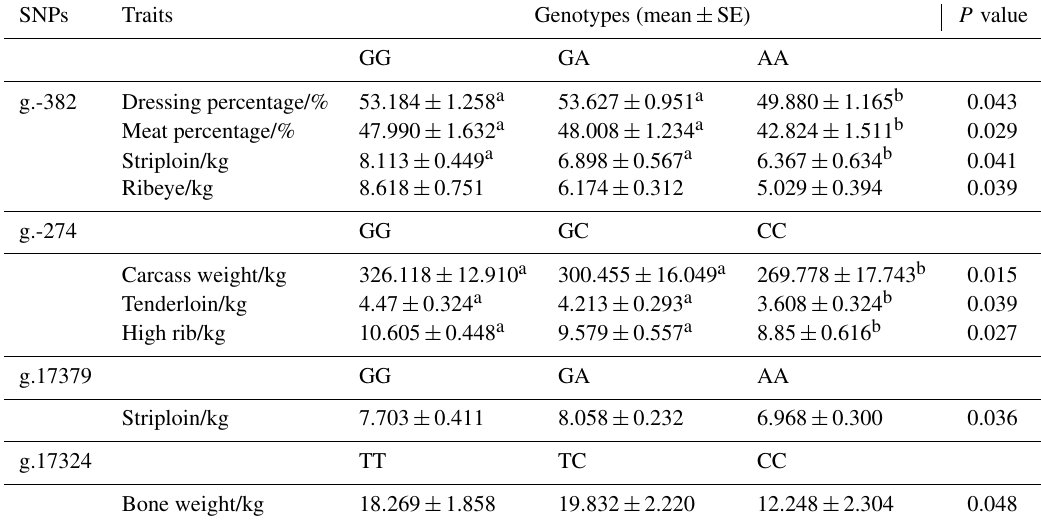
Table 3. Significant SNP, genotype, and carcass trait